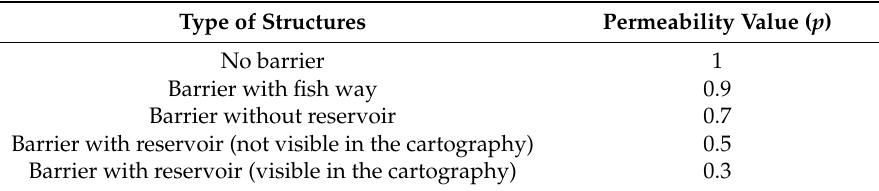
Figure 3. Workflow used to calculate connectivity indicators. Table 1. Permeability conditions for fish in the obstacles (dams or